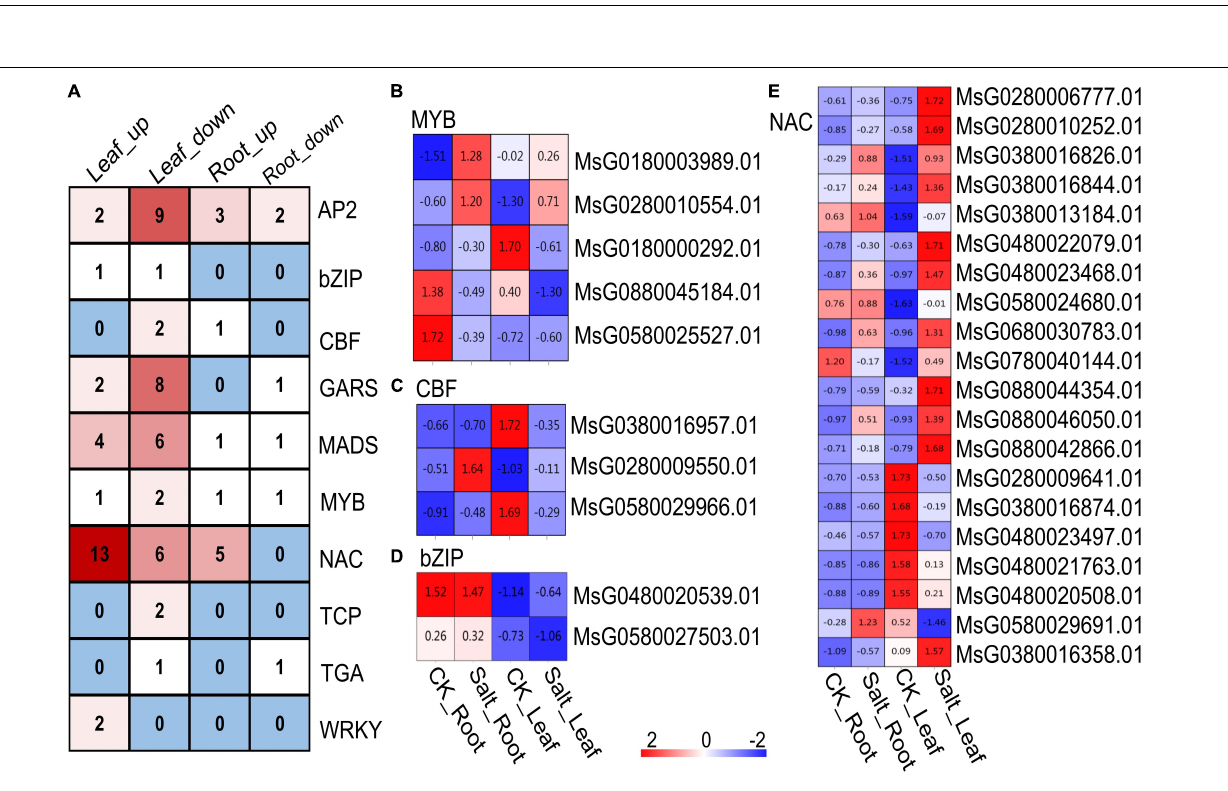
FIGURE 3 | Transcriptome analysis. (A) Number of upregulated genes (red) and downregulated genes (blue) between alfalfa seedlings under salt stress and those under normal conditions. (B) Distribution of DEGs in the leaves and roots of alfalfa. The inner circle indicates the DEGs in the roots, and the outer circle indicates the DEGs in the leaves. (C) Upregulated DEGs common to the leaves and roots. (D) Downregulated DEGs common to the leaves and roots. (E) Heatmap clustering of all the DEGs according to their expression abundance. The different colors indicate different levels of expression abundance.